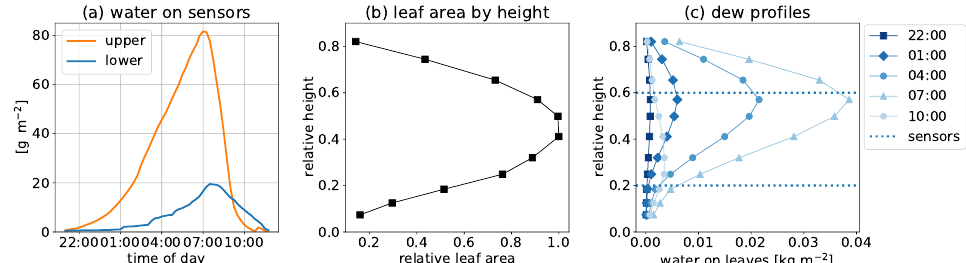
Figure 5. Vertical distribution of dew, with: ( a ) water detected on upper and lower sensors [g m − 2 ] during dew accumulation and dissipation, averaged over 14 dew events; ( b ) averaged vertical profiles of leaf area for mid-to-late season, with leaf area relative to maximum leaf area and height relative to maximum plant height; and ( c ) resulting vertical dew profiles changing during the night, including relative heights of sensors.